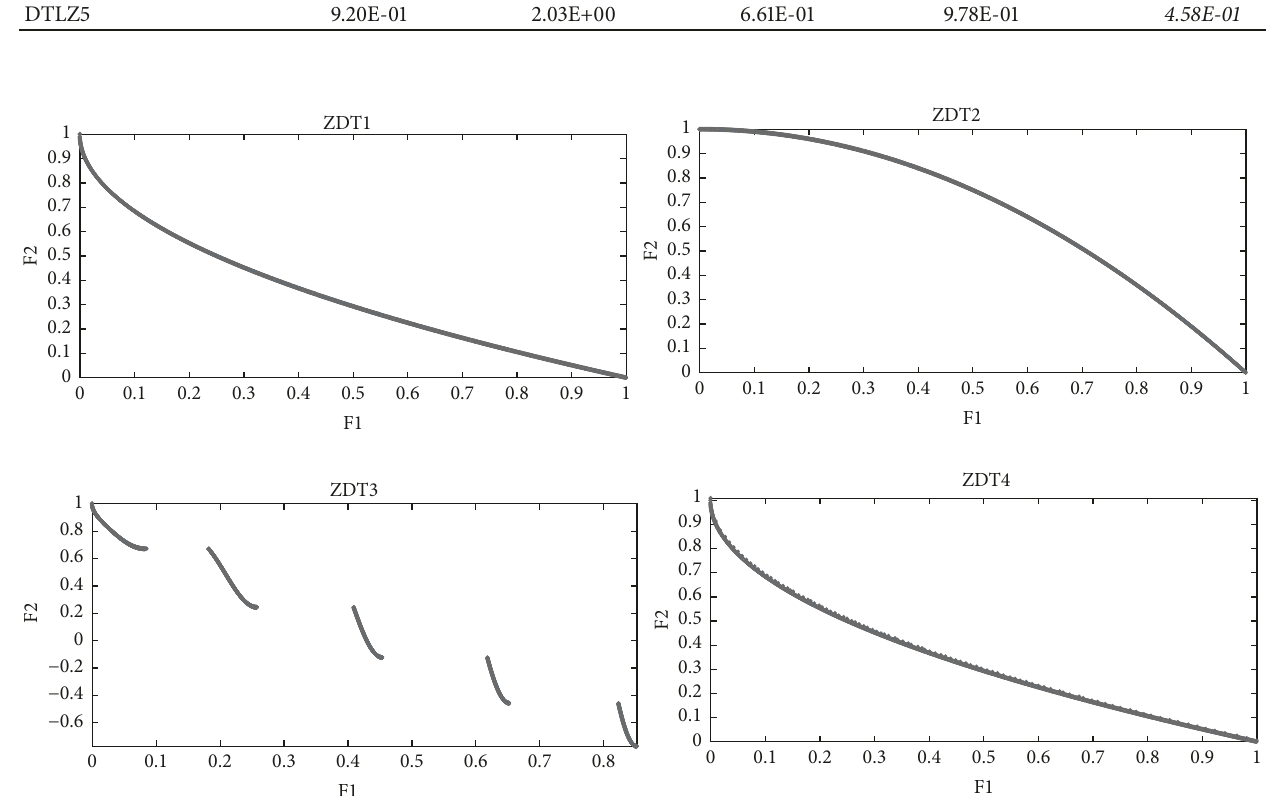
Figure 5: Pareto optimal solutions obtained by LCNSGA-III for